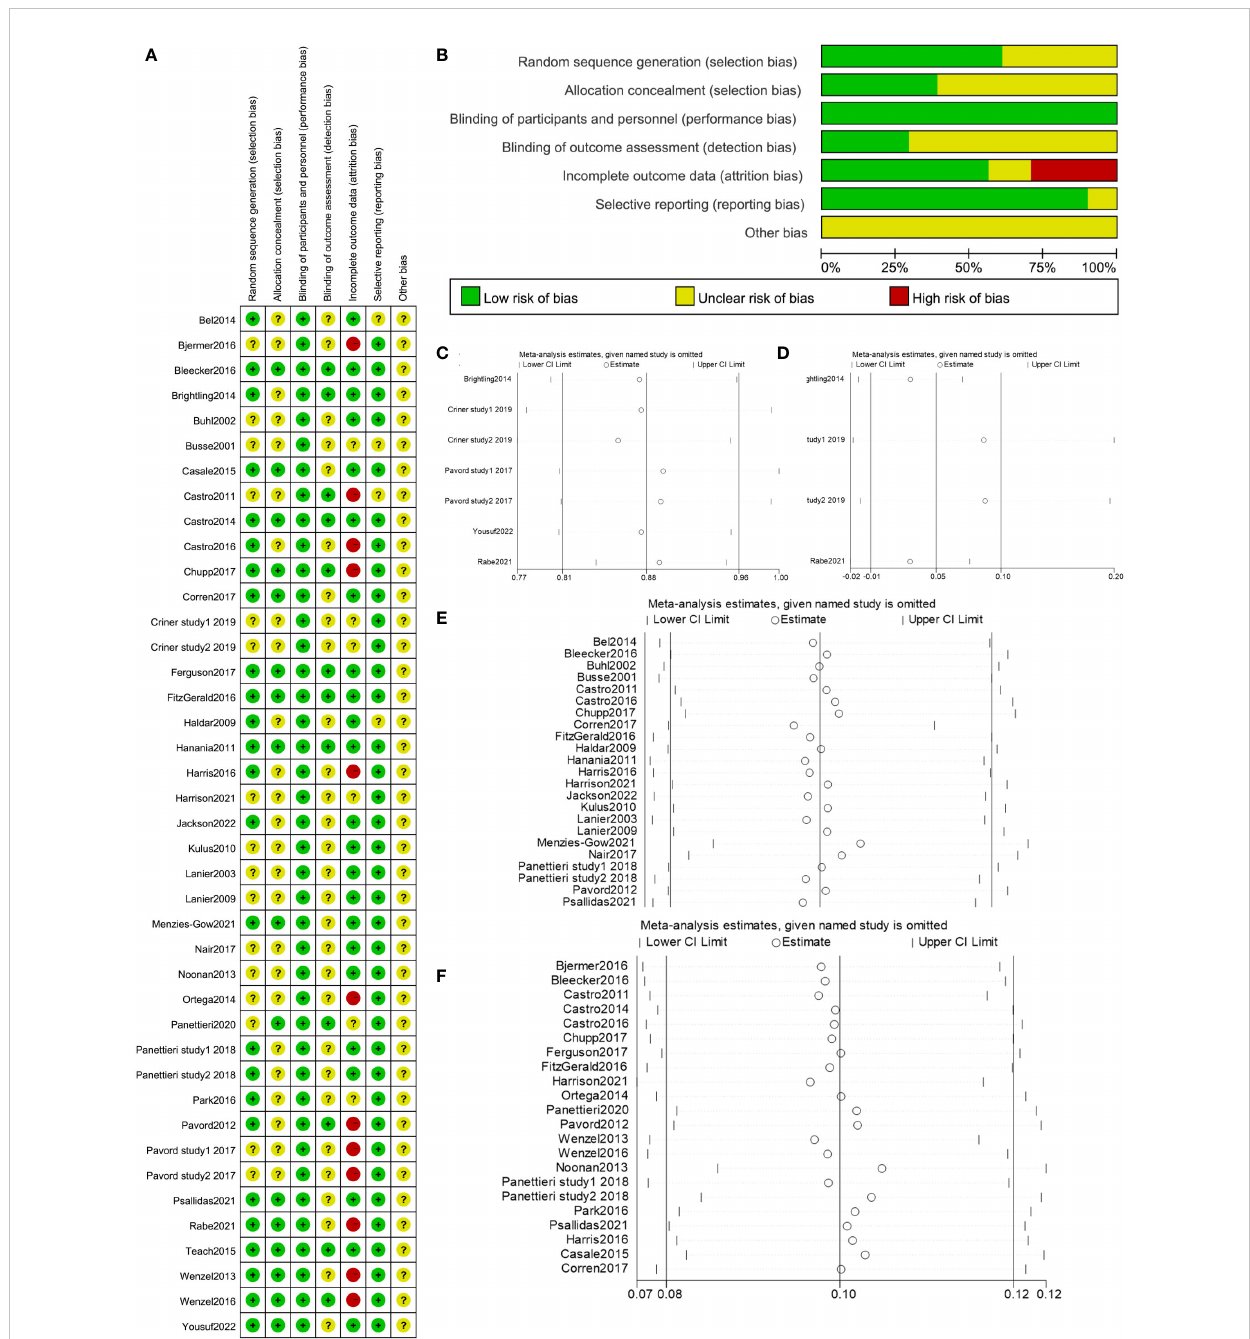
FIGURE 3 (A, B) Risk of bias summary of included studies. (C) Sensitivity analysis of exacerbation rate in COPD in the meta-analysis. (D) Sensitivity analysis of change in FEV1 from baseline in COPD in the meta-analysis. (E) Sensitivity analysis of exacerbation rate in asthma in the meta-analysis. (F) Sensitivity analysis of change in FEV1 from baseline in asthma in the